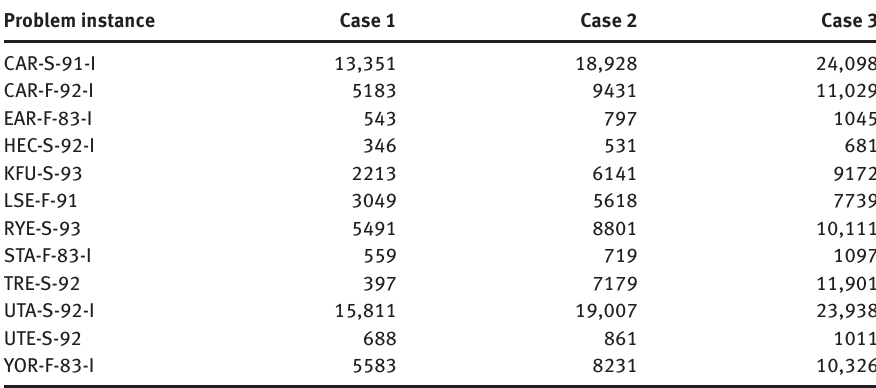
Table 4. Average Runtime of the HABC on Each Problem Instance of the